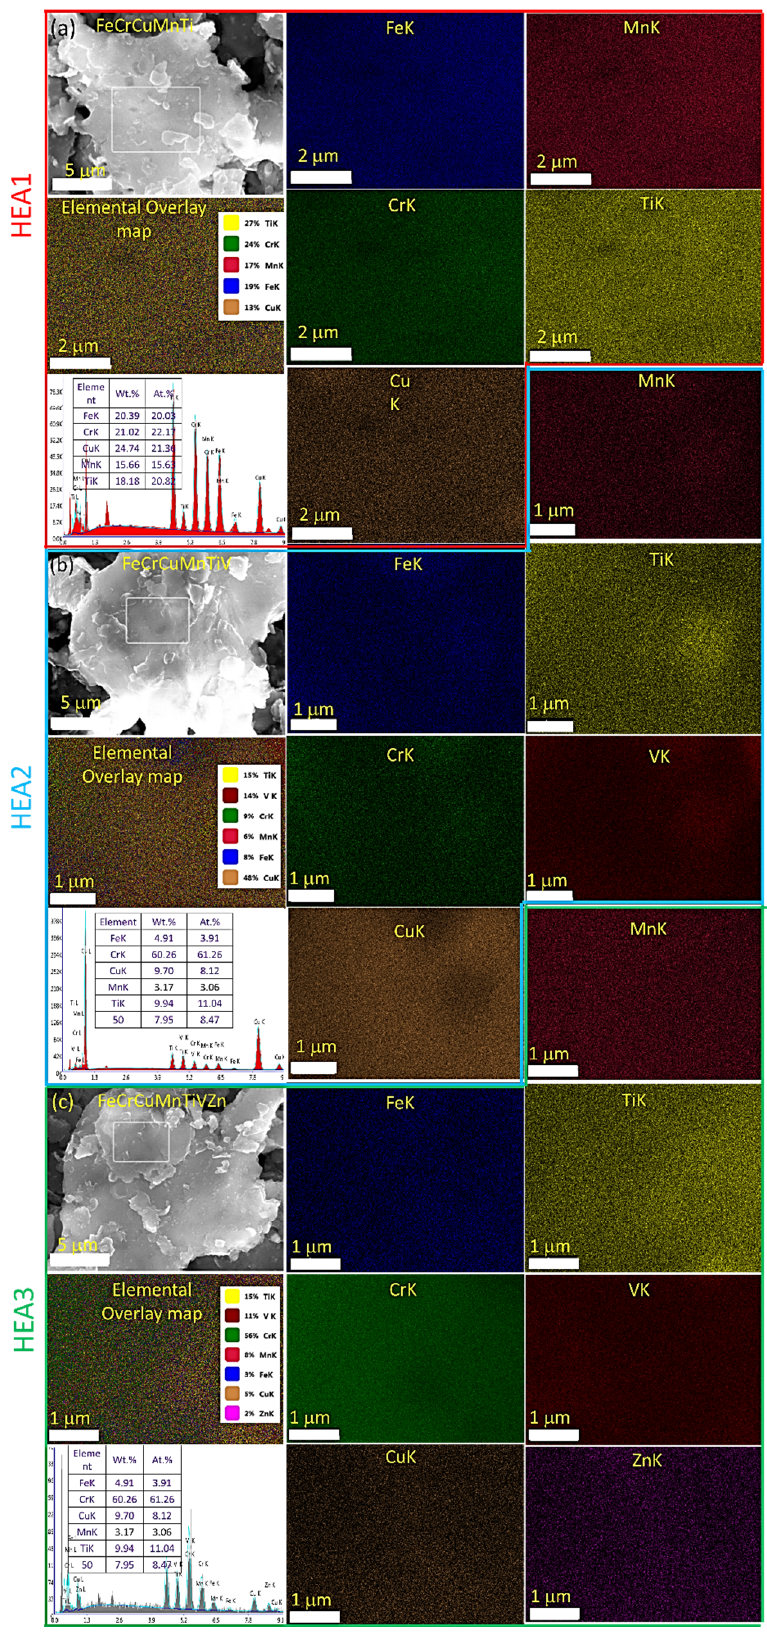
Figure 6. HRSEM EDS elemental mapping at high magnification showing multiple solid solutions and elemental analyses of three high-entropy alloys: ( a ) FeCrCuMnTi; ( b ) FeCrCuMnTiV; and ( c ) FeCrCuMnTiVZn.